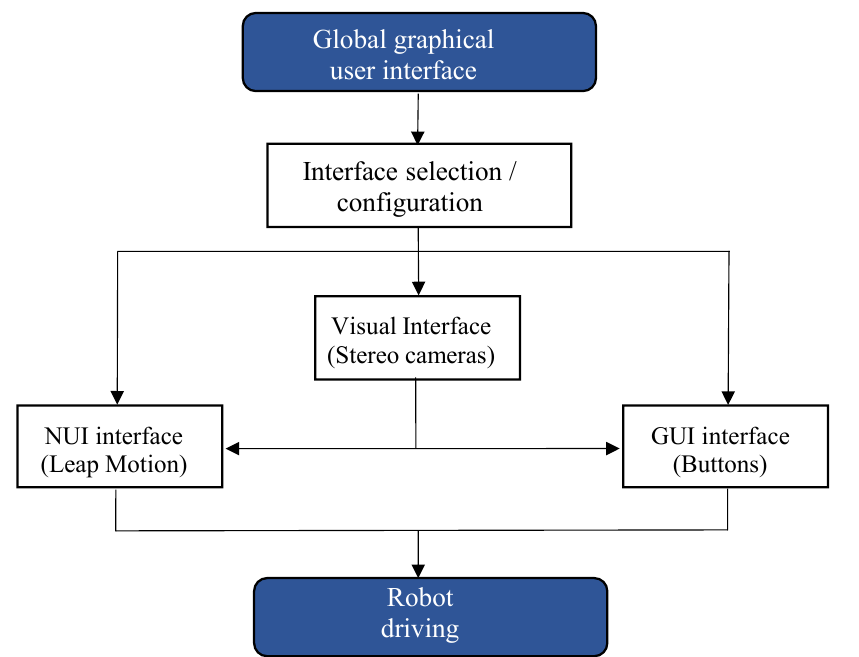
Figure 7. Different human–robot interaction channels.